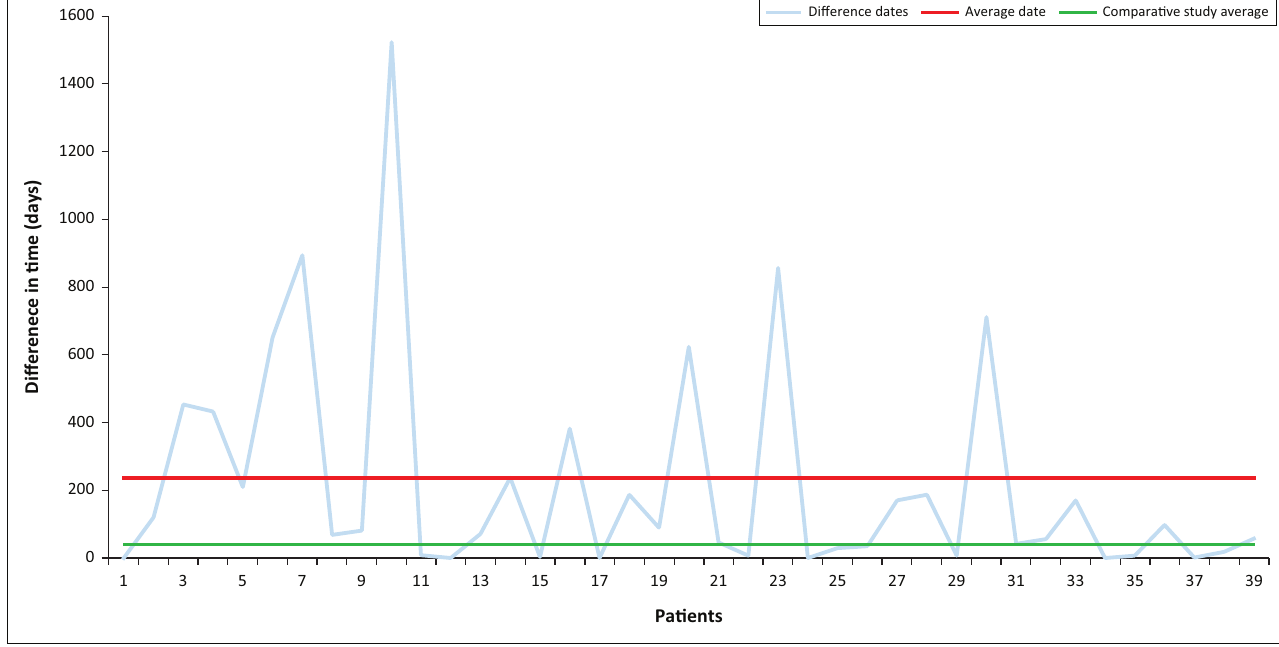
FIGURE 9: Time difference between magnetic resonance imaging and